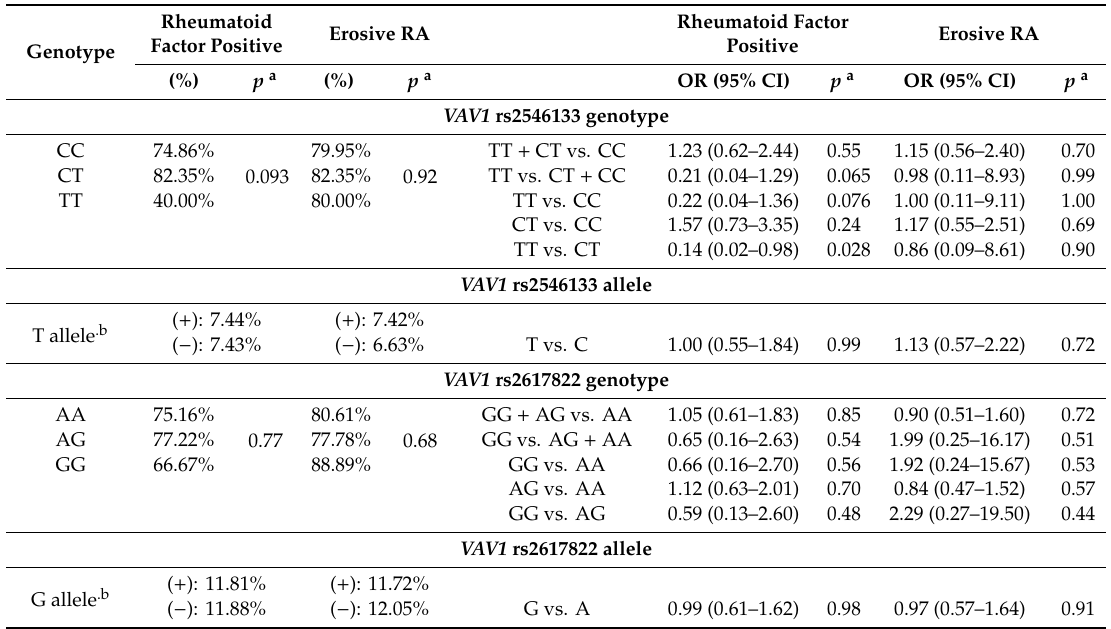
Table 4. Analysis of clinical parameters (rheumatoid factor and erosive RA) in relation to VAV1 rs2546133 and rs2617822